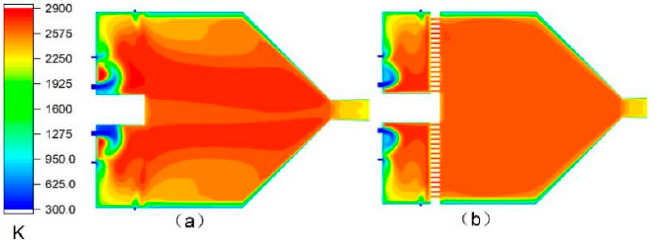
Figure 6. Temperature distribution inside the spray gun: ( a ) second meshes and ( b ) fourth meshes.